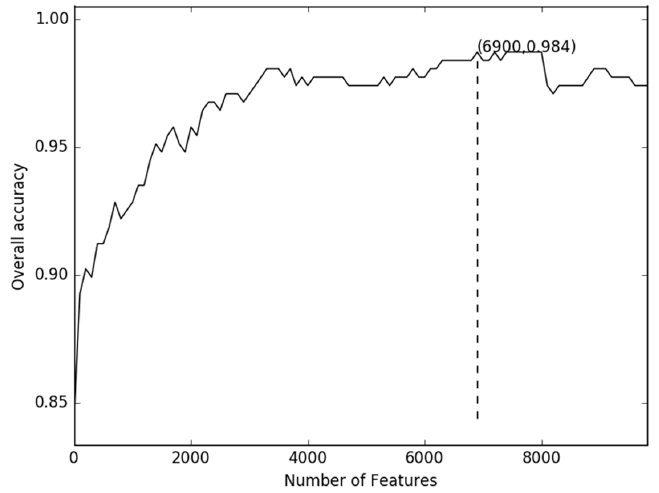
Figure 2. The incremental feature selection curves for the values of accuracy against the discrete feature vector.